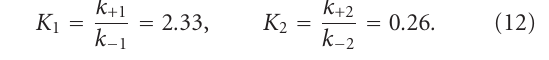
profiles approach the stable node of the extractive profile